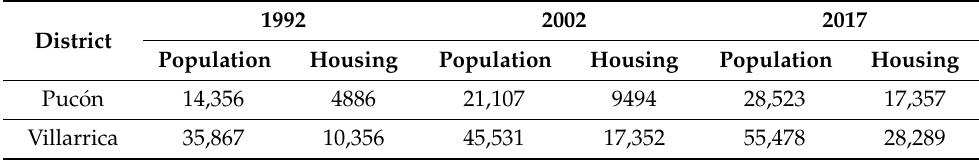
Table 2. Population and housing data for the districts of Puc ó n and Villarrica, 1992–2017. 1992 2002 2017 District Population Housing Population Housing Population Housing Puc ó n 14,356 4886 21,107 9494 28,523 17,357 Villarrica 35,867 10,356 45,531 17,352 55,478